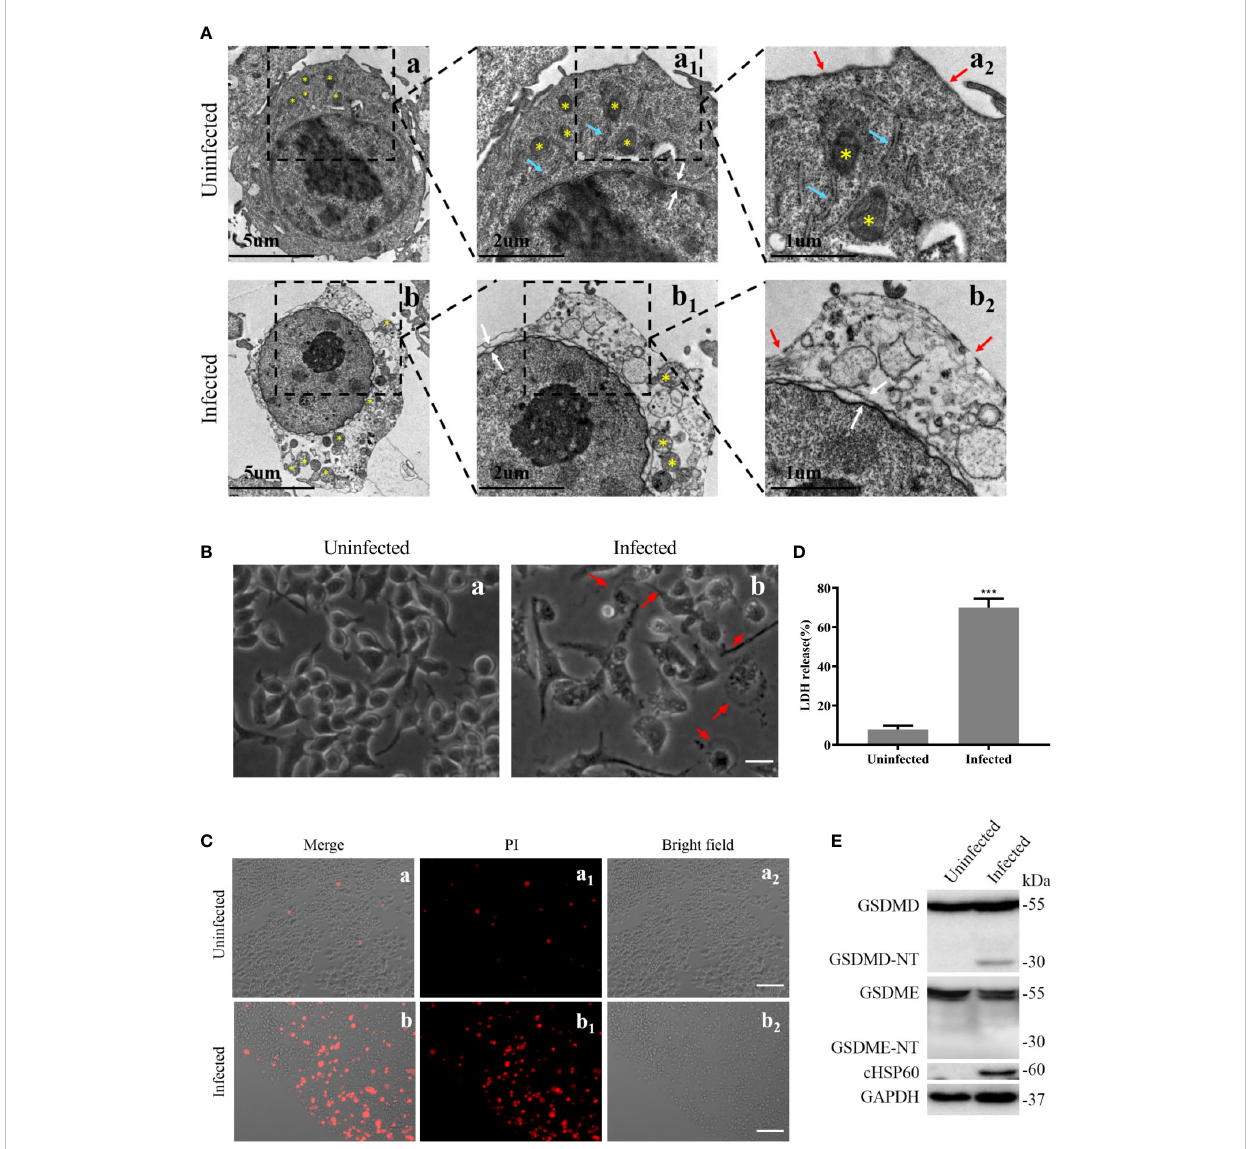
FIGURE 1 Pyroptosis induced by C. trachomatis infection is accompanied by activation of GSDMD in macrophages. RAW264.7 cells were infected with C . trachomatis (MOI=5) for 12 hours. (A) . TEM displayed ultrastructural changes of C. trachomatis -infected macrophages. Yellow stars indicated mitochondria, and blue arrowheads represented Golgi, red and white arrowheads represented plasma membrane ruptures and nuclear envelope respectively. (B) . Light microscopy revealed signs of pyroptosis in the infected macrophages. Red arrowheads indicate examples of pyroptotic infected cells. Scale bars, 40 m m. (C) . PI staining showed increasing membrane permeability of infected RAW 264.7 cells compared with uninfected cells. Scale bars, 20 m m. (D) . LDH released in the supernatant was measured to check the release of cellular contents in the RAW 264.7 cells. (E) . Immunoblot analysis showed the activation of GSDMD and GSDME in C. trachomatis- infected RAW264.7 cells. cHSP60 is as marker of C. trachomatis infection. ***P<0.001, vs the uninfected group.